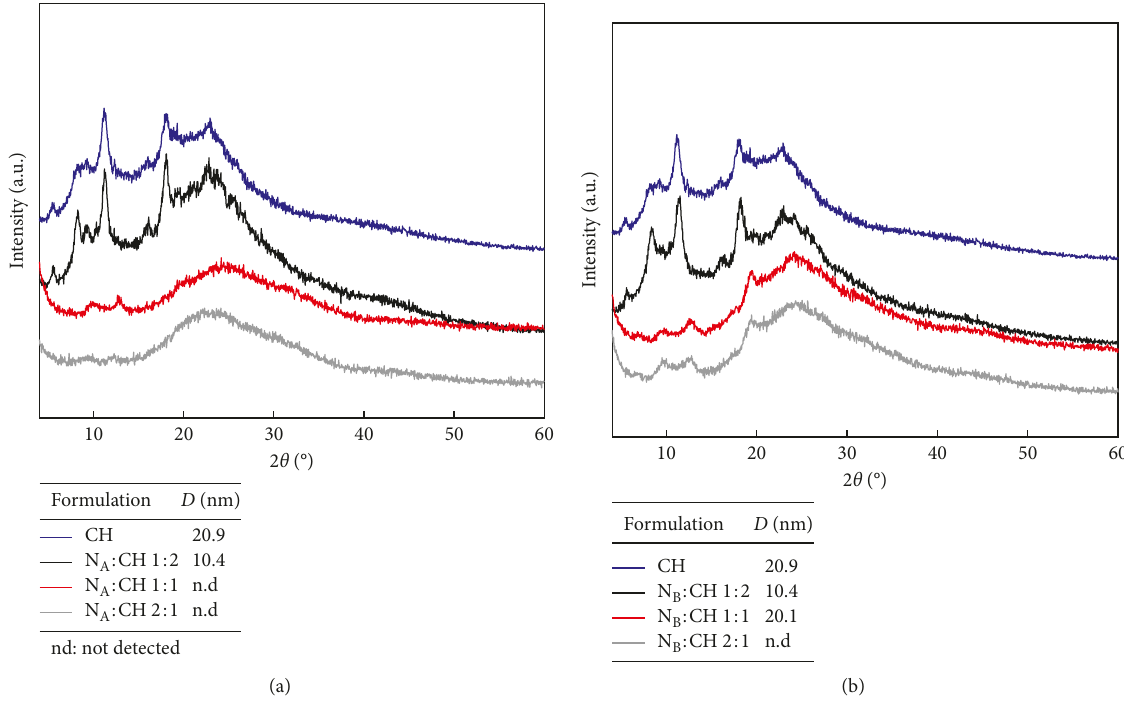
Figure 3: X-ray diffractograms of nanocomposites formulated with different N size estimated by using the Debye–Scherrer equation.